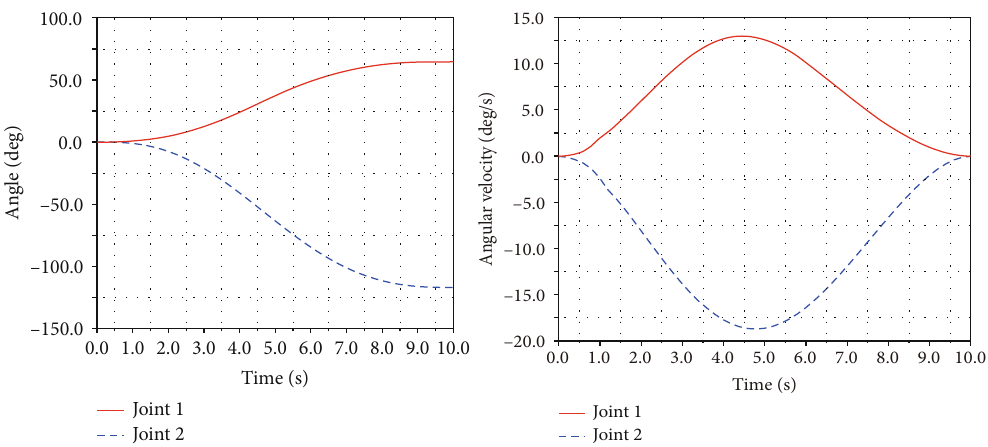
Figure 6: Optimized trajectories of joints for the planning case of zero attitude